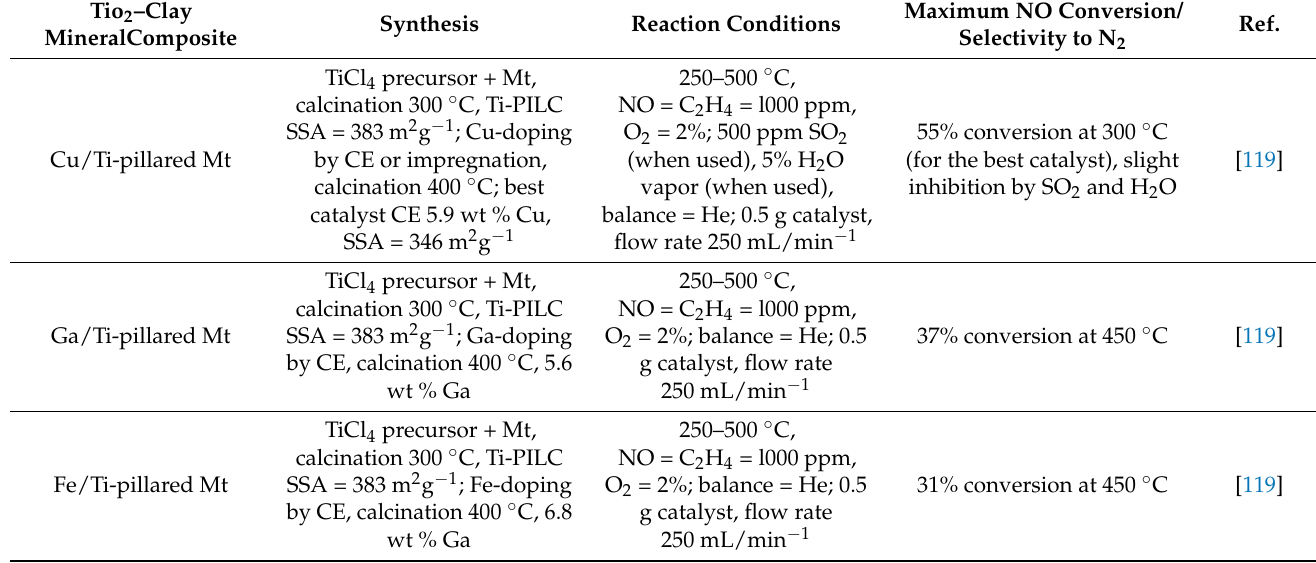
Table 2. Summary of the main synthesis and catalysis data for the most relevant examples of TiO 2 –clay mineral composites used as catalysts for the HC SCR of NO x (Mt—montmorillonite, CE—cation exchange, GHSV—gas hourly space velocity). Tio 2